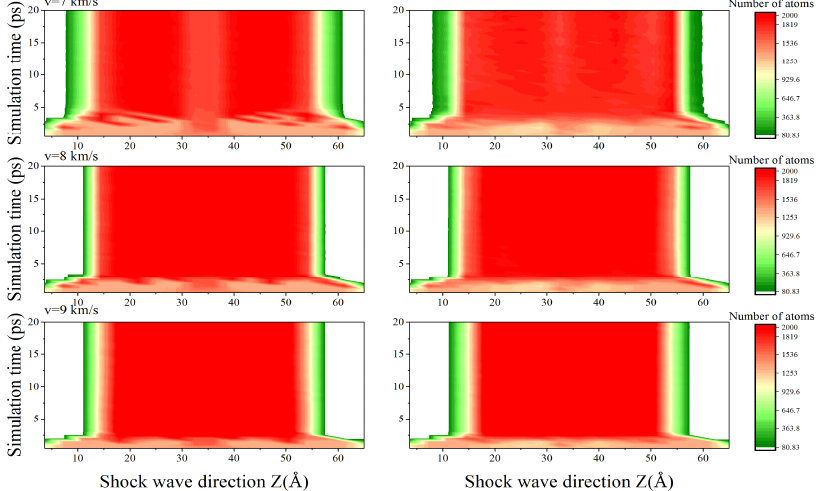
Figure 9. Time-position (t–z) diagrams exhibit bin-density distributions during the travel of the shock